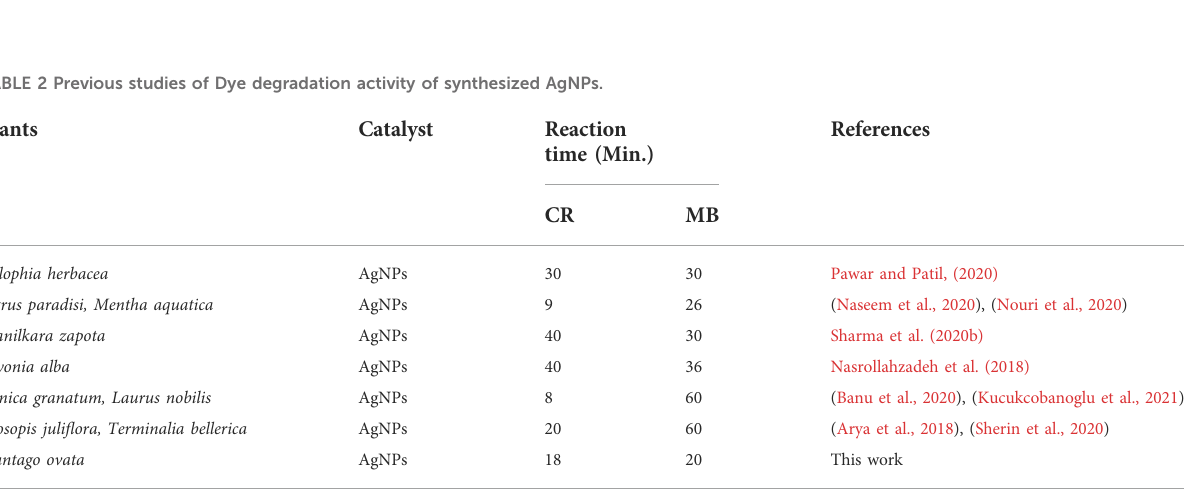
TABLE 2 Previous studies of Dye degradation activity of synthesized AgNPs. Plants Catalyst Reaction